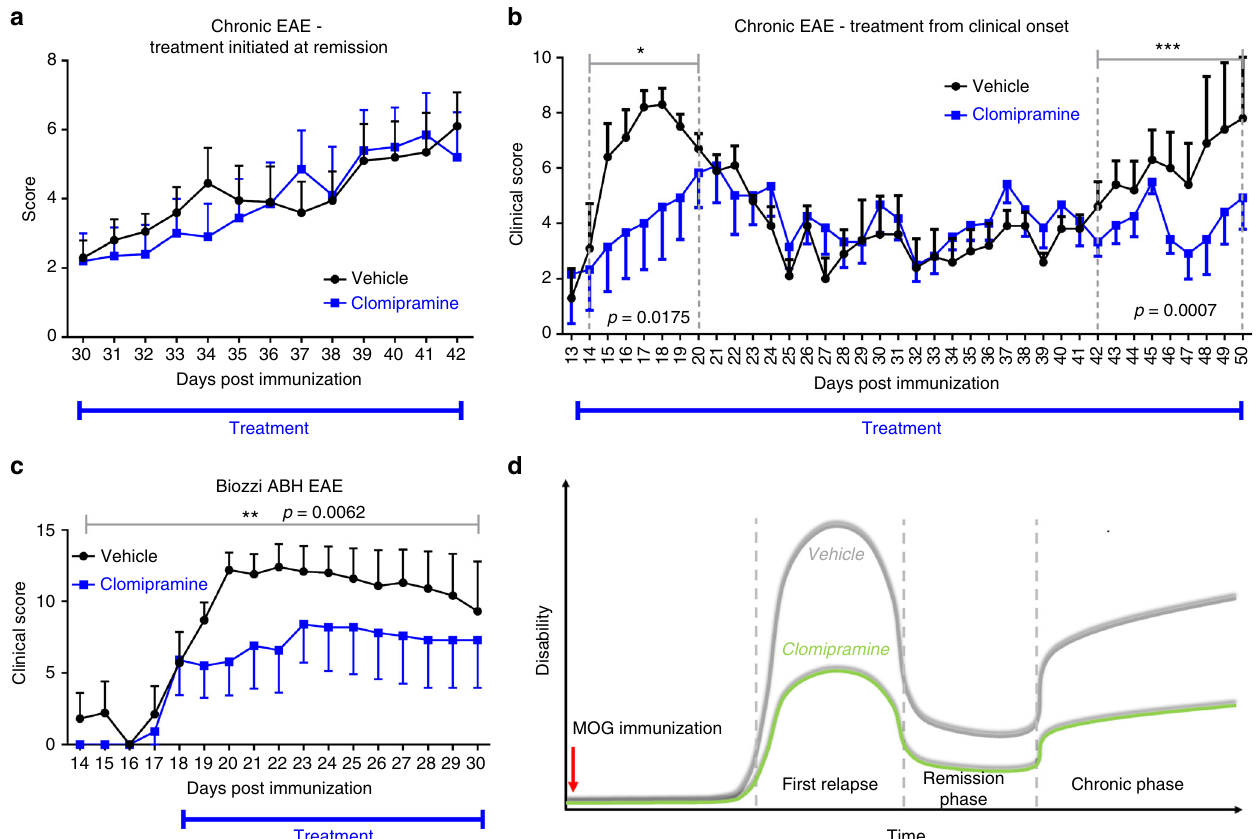
Fig. 10 Clomipramine improves the chronic phase of EAE. a Female C57BL/6 (age 8 – 10 weeks) MOG-immunized mice were treated with clomipramine IP (25 mg/kg) or PBS (vehicle) from remission after the fi rst relapse, and this did not affect disease score between the groups ( n = 10 vehicle, n = 10 clomipramine). b In a second experiment, MOG-immunized C57BL/6 mice were treated from onset of clinical signs. Here, clomipramine reduced